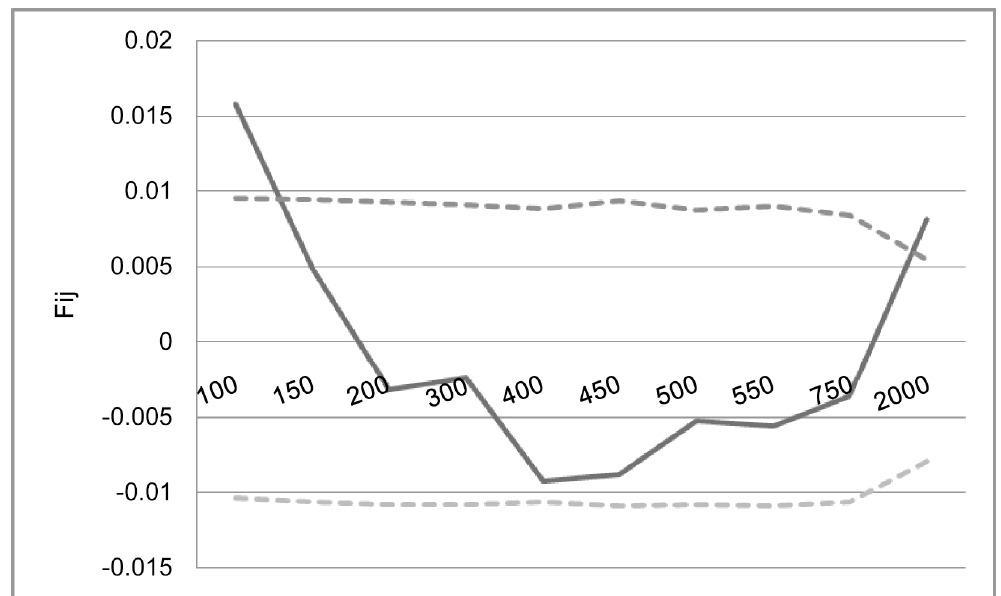
Fig 6. Results of spatial genetic structure analysis in the second intron S -alleles of P . africana . Significant autocorrelation was detected in the first distance class (up to 100 m) between individuals. X-axis is spatial distance between individuals in metres, y-axis is Loiselle ’ s kinship coefficient for the second intron S -alleles